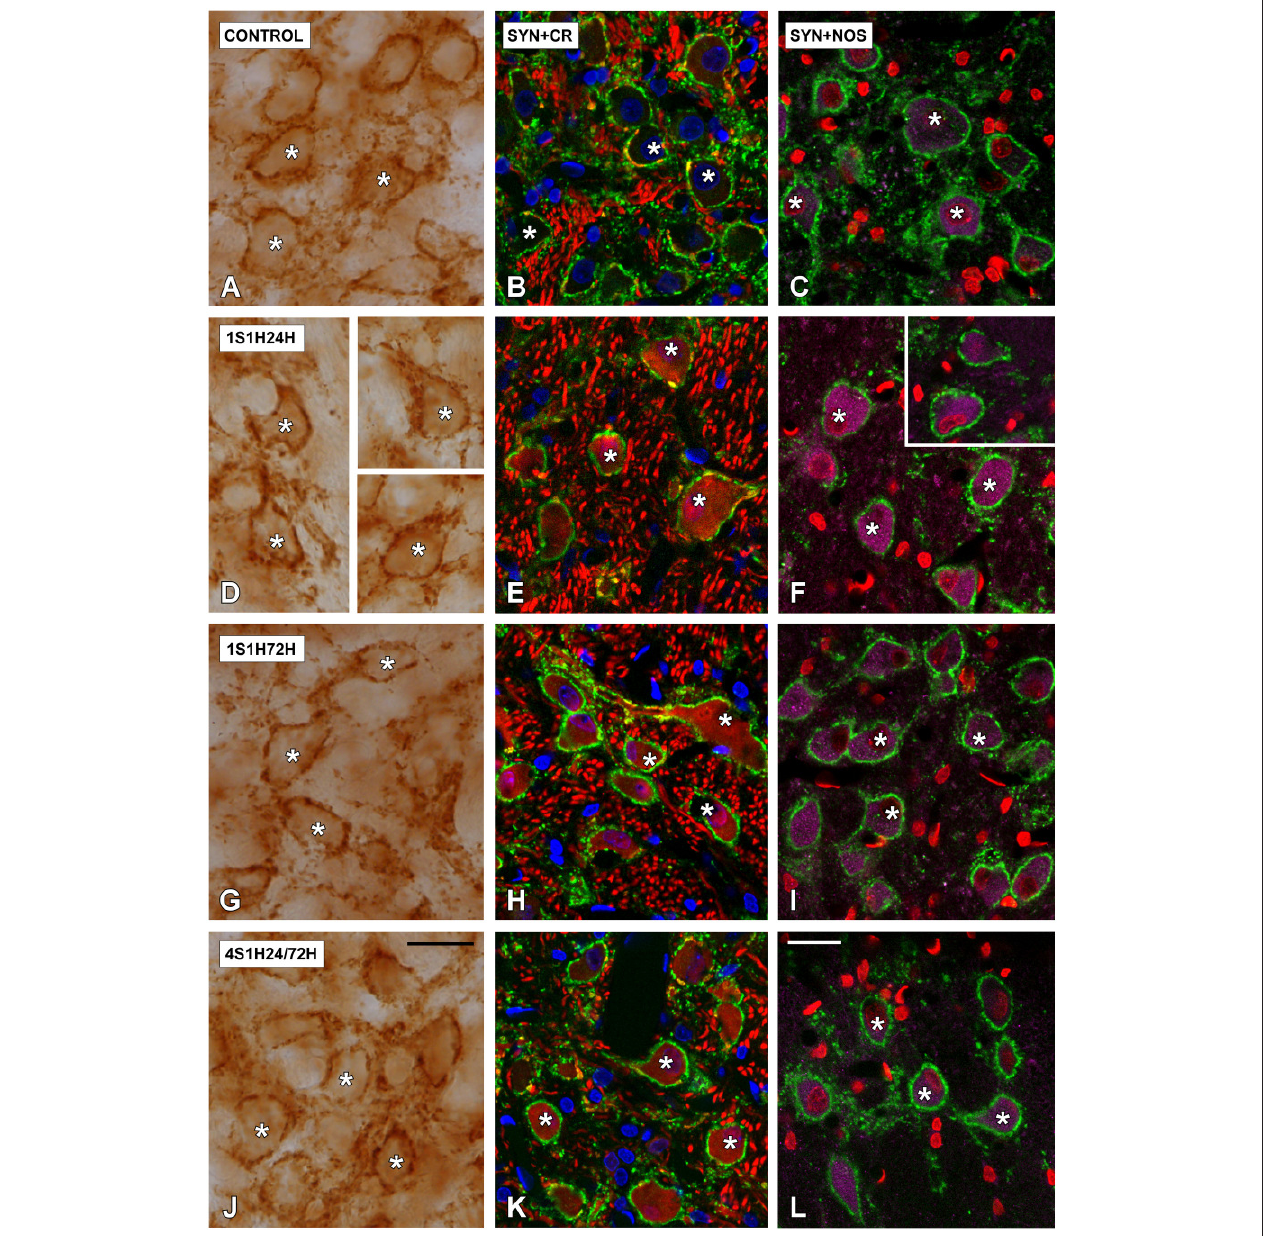
FIGURE 12 | Digitized high magnification images depicting SYN immunostaining in the AVCN in control and noise-exposed rats. The staining consisted of punctate deposits in the neuropil and perisomatic profiles that were seen surrounding unstained cochlear nucleus neurons (asterisks in A,D,G,J ) immunostained either with CR (asterisks in B,E,H,K ) or with NOS (asterisks in C,F,I,L ). Although there were no differences in the distribution pattern of SYN among groups, significant increases in CR and NOS staining were evident in 1S1H24H (E,F) rats when compared to control (B,C) . Scale bars represent 25 µ m in (J,L)